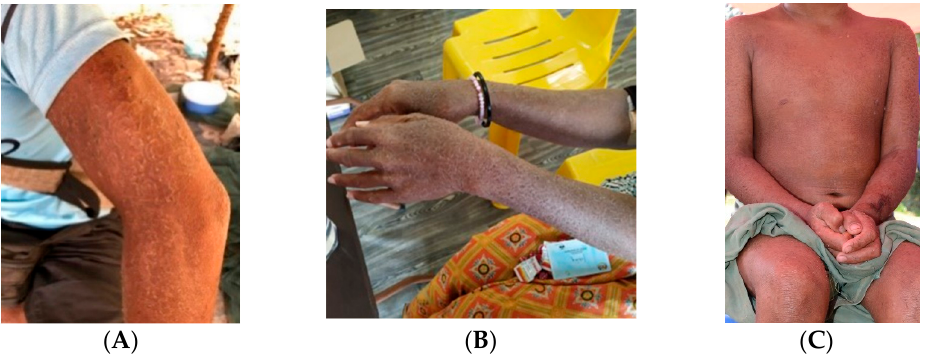
Figure 1. Various skin presentations of tinea imbricata among indigenous communities in Malaysia. ( A ) Patient from an indigenous background with tinea imbricata affecting the whole upper limb. ( B ) Signature concentric annular lesions on both upper limbs. ( C ) The annular lesions overlap each other to form a characteristic lamellar pattern. Photos ( A , B ) were taken with consent by Yi Xian Er in Kuala Koh, Kelantan, Malaysia and Baling, Kedah, Malaysia, respectively. Photo ( C ) was taken with consent by Dr. Kin Fon Leong.